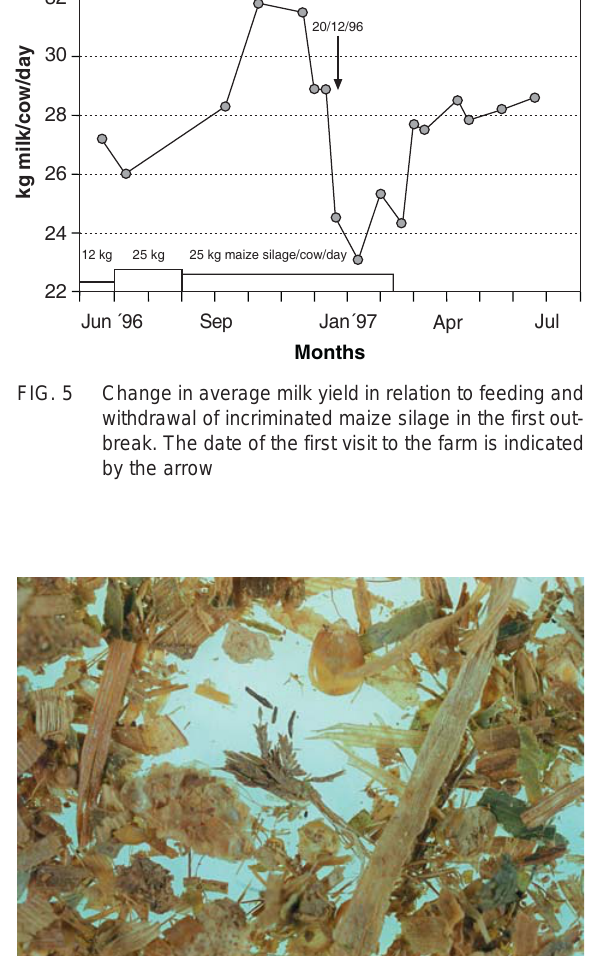
FIG. 8 Cyperus esculentus , yellow nut sedge